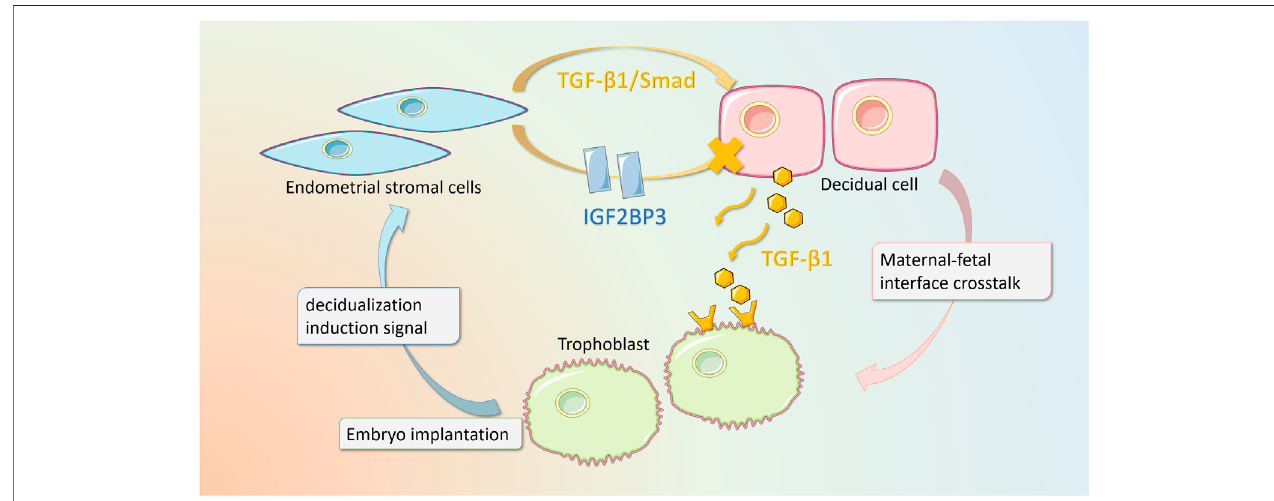
FIGURE7| SchematicdiagramofIGF2BP3playingaregulatoryroleindecidualizationandmaternal – fetalinterfacecrosstalk.Ourstudyelucidatesthatinrecurrent pregnancy loss, the overexpression of IGF2BP3 in endometrial stromal cells leads to an impairment of decidualization through the inhibition of TGF- β 1/Smad-signaling pathway. In addition, this mutation interferes with the cytokine cross talk between decidual cells and trophoblast cells, which in turn inhibits trophoblast migration and invasion.